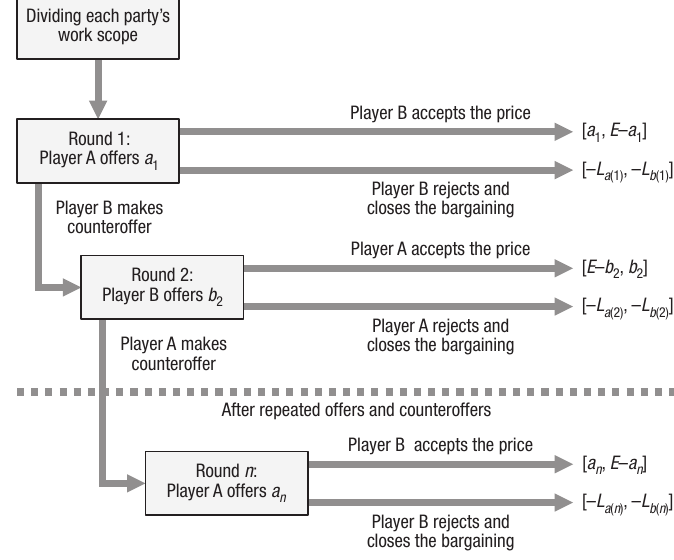
Fig. 1. The sequential bargaining